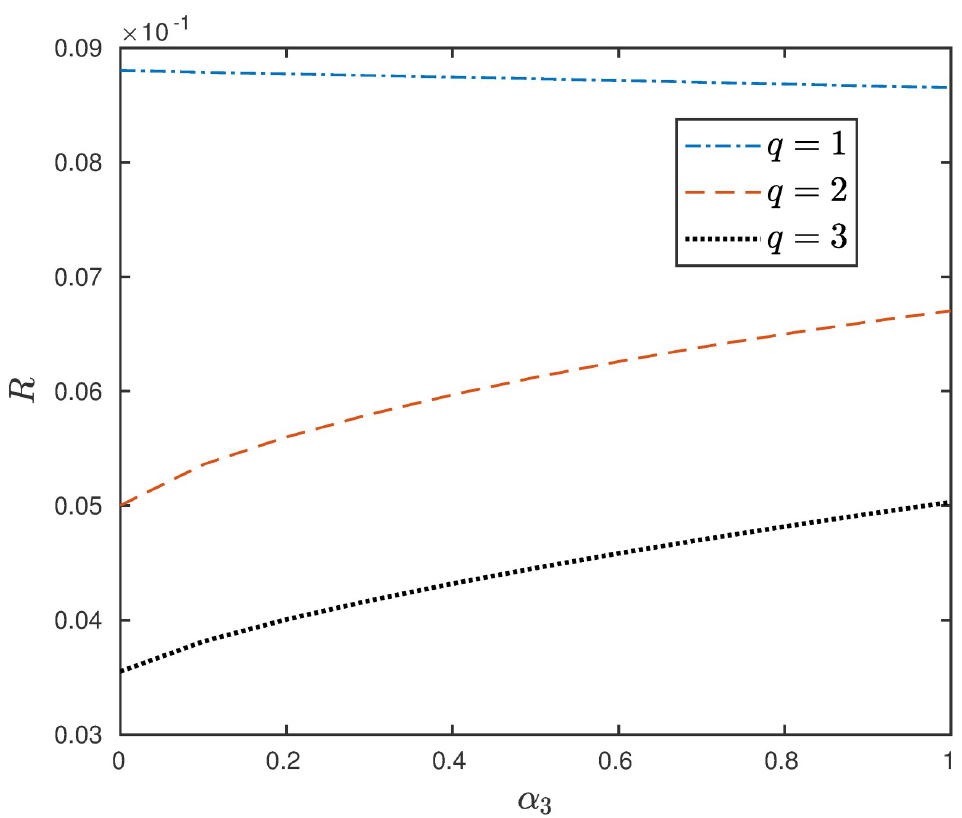
Fig 5. The steady-state output rate R as a function of α 3 for a EFEIOD with n = 9, ℓ = 2, λ 0 = 1, λ i = 1 for all i except λ 5 = 0.01, α i = 0 and r = 1/ q